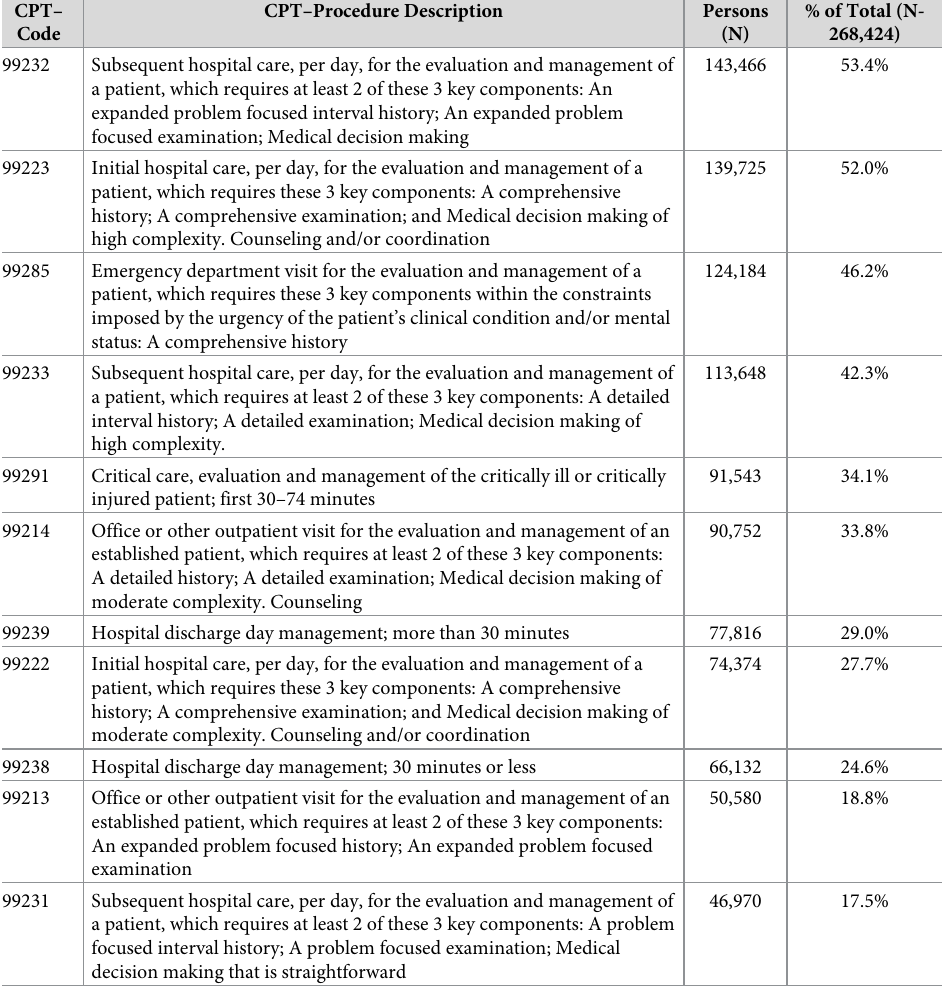
Table 6. Most common evaluation and management procedures codes assigned in the one day before through 14 days following first AMI diagnosis, any healthcare setting (2014–2017) �